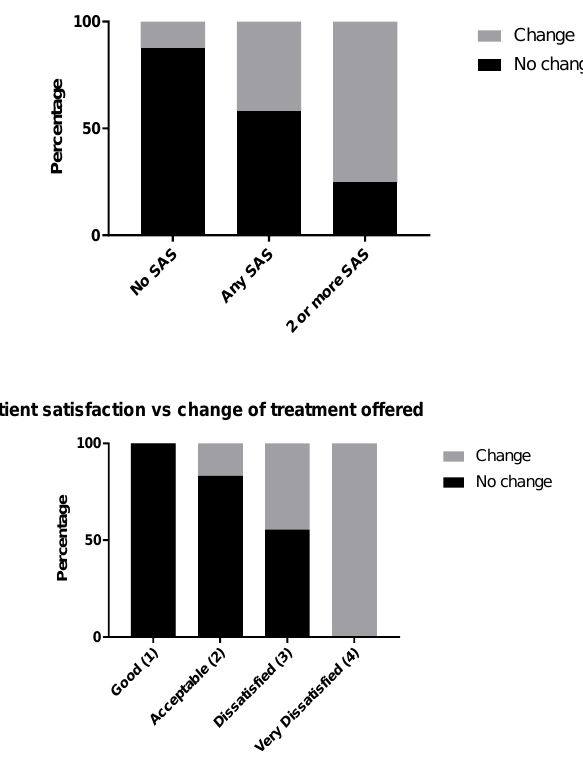
Figure 4. ( A ) Severe neurogenic bowel dysfunction (NBD) score associates with treatment change. ( B ) Linear association of special attention symptoms (SAS) and treatment change. ( C ) Inverse association between patient satisfaction and treatment change.